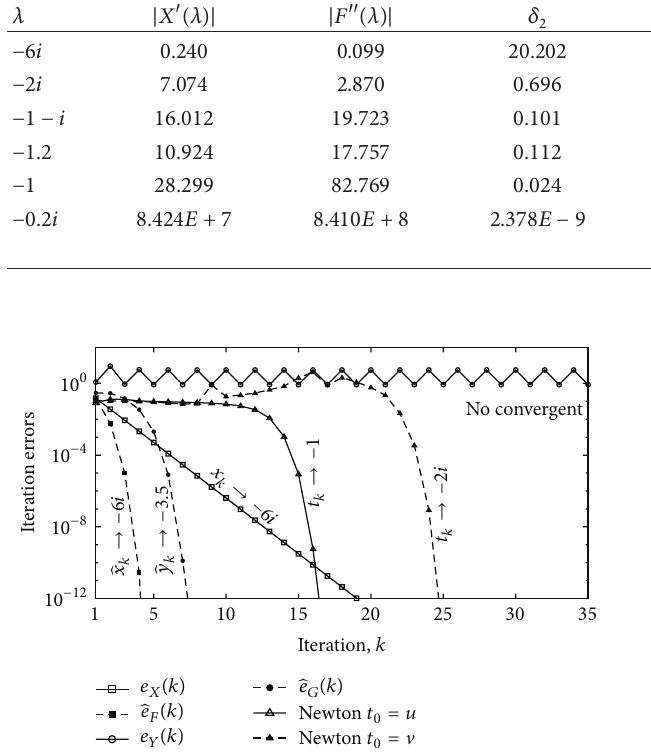
Figure 2: Example 1. Iteration errors. Pivots are 𝑢 = −0.7674 − 5.7182𝑖 and V = −1.9326 + 0.7182𝑖